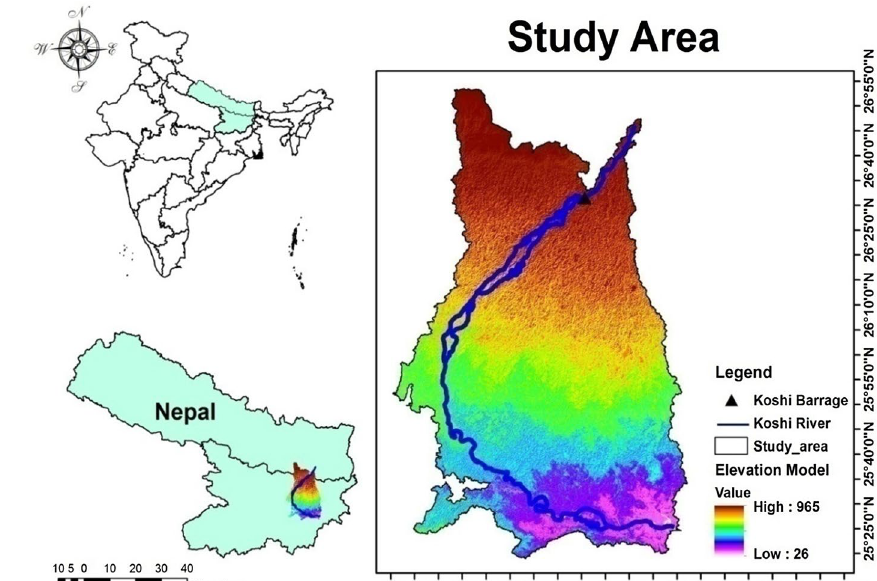
Fig. 2 Location of the study area with elevation level data